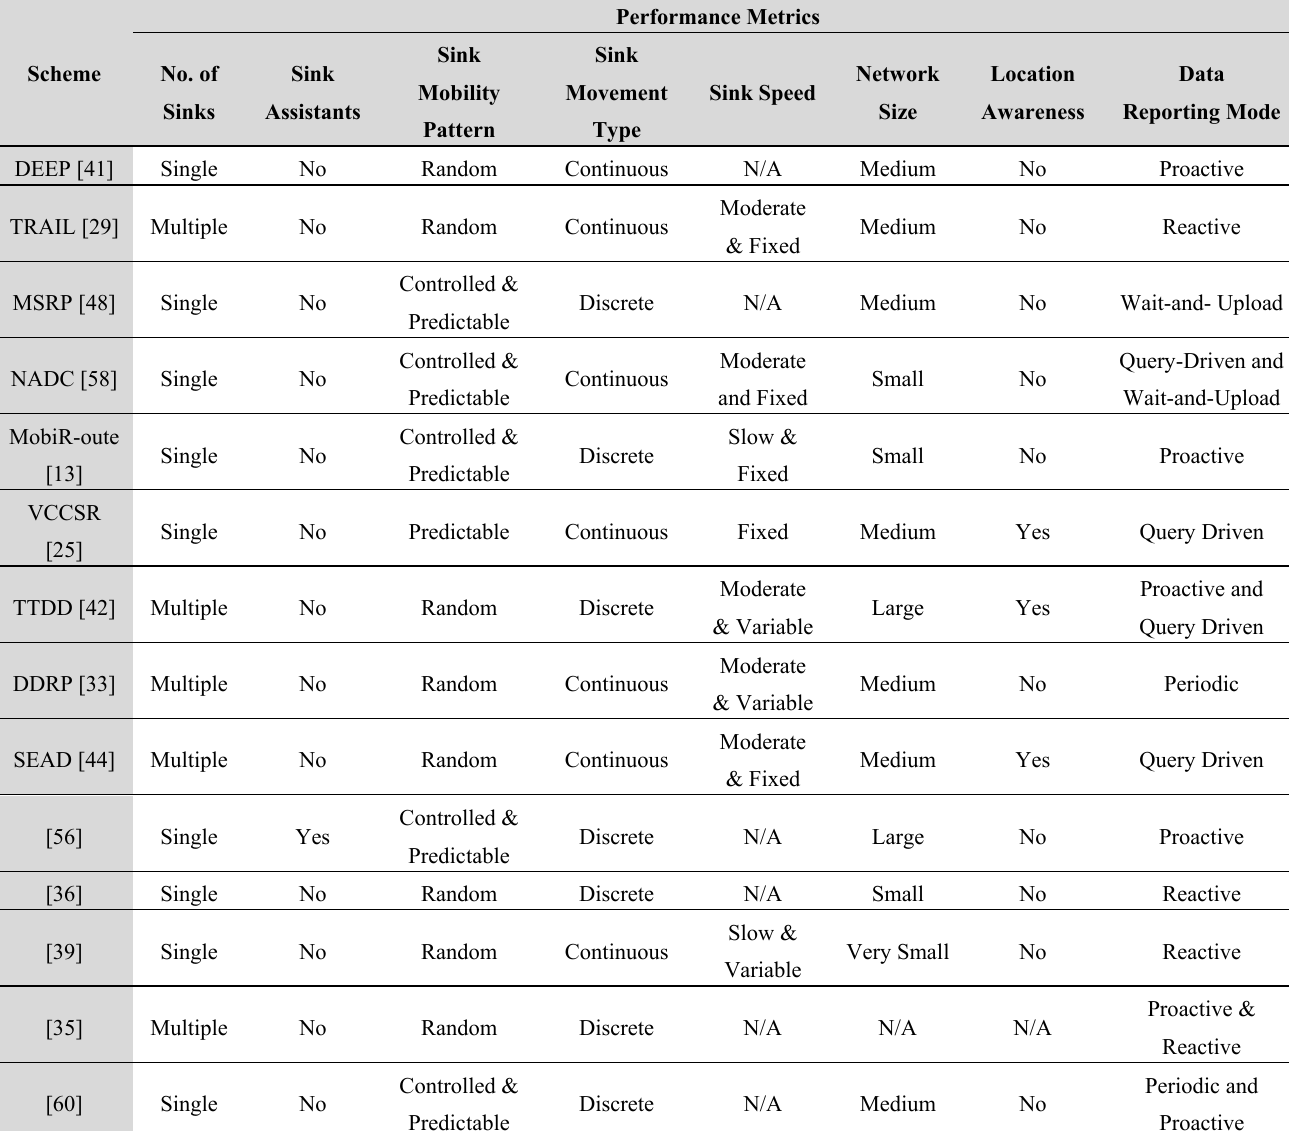
Table 4. Comparative study of energy efficiency based data collection schemes.